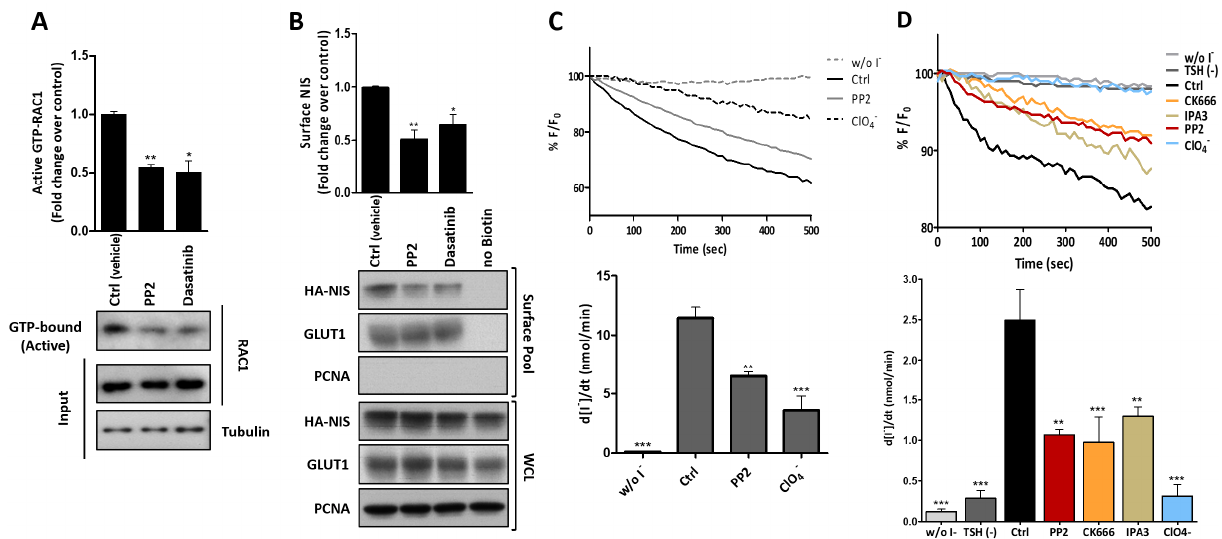
Figure 9. SRC functions upstream of RAC1 to promote NIS residency at the PM. ( A ) HA-NIS-TPC1 were treated with either the vehicle or one of two SRC inhibitors, PP2 (2 µM for 1 h) or Dasatinib (150 nM for 1 h), and the endogenous RAC1 activation status was assessed by monitoring the levels of active, GTP-bound RAC1 with CRIB-domain pull-down assays. The endogenous levels of the total (input) and GTP-bound RAC1 in the pulled-down fraction were assessed by WB using an anti-RAC1 antibody. The total lysates were further probed for tubulin as the loading control. Plotted is the densitometry analysis of the WB bands (means ± SEM of three independent assays), using ImageJ software. One-way ANOVA analysis detected significant differences between the treatments (F = 19.86; p = 0.0186). Post-hoc Dunnett’s tests were used to identify significant variations relative to the control (Ctrl) conditions (* p ≤ 0.05; ** p ≤ 0.01). ( B ) HA-NIS-TPC1 cells treated as in ( A ) were analyzed by surface protein biotinylation. The surface fraction or correspondent whole-cell lysates (WCL) were analyzed by WB, as indicated. The ‘no Biotin’ condition, corresponding to cells that were not incubated with biotin, was used to control the specificity of the biotinylated protein pull-down. PCNA expression served as the loading (WCL) and intracellular protein contamination control (Surface pool). GLUT-1 served as the positive loading control for cell surface protein extracts. The WB bands were quantified as in ( A ), and were plotted as the means ± SEM of at least three